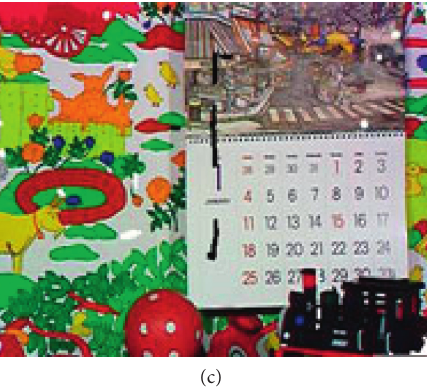
Figure 9: Artificially degraded datasets used for performance comparison: (a) “football _1,” (b) “football _2,” and (c) “calendar”.